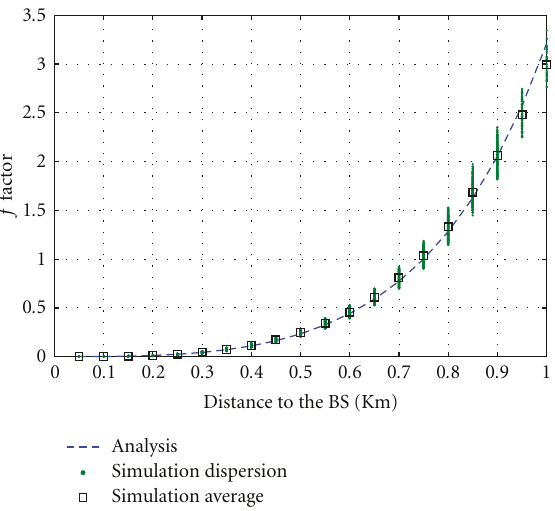
Figure 7: OCIF versus distance to the BS; comparison of the fluid model with simulations (average value and dispersion over 500 snapshots) on a hexagonal network with η = 3.